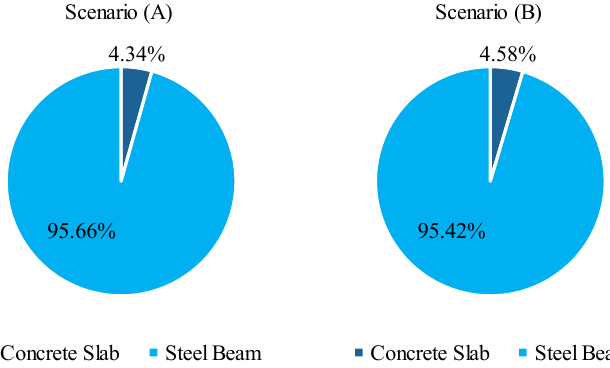
Figure 8. Contribution to the cost of each structural element.